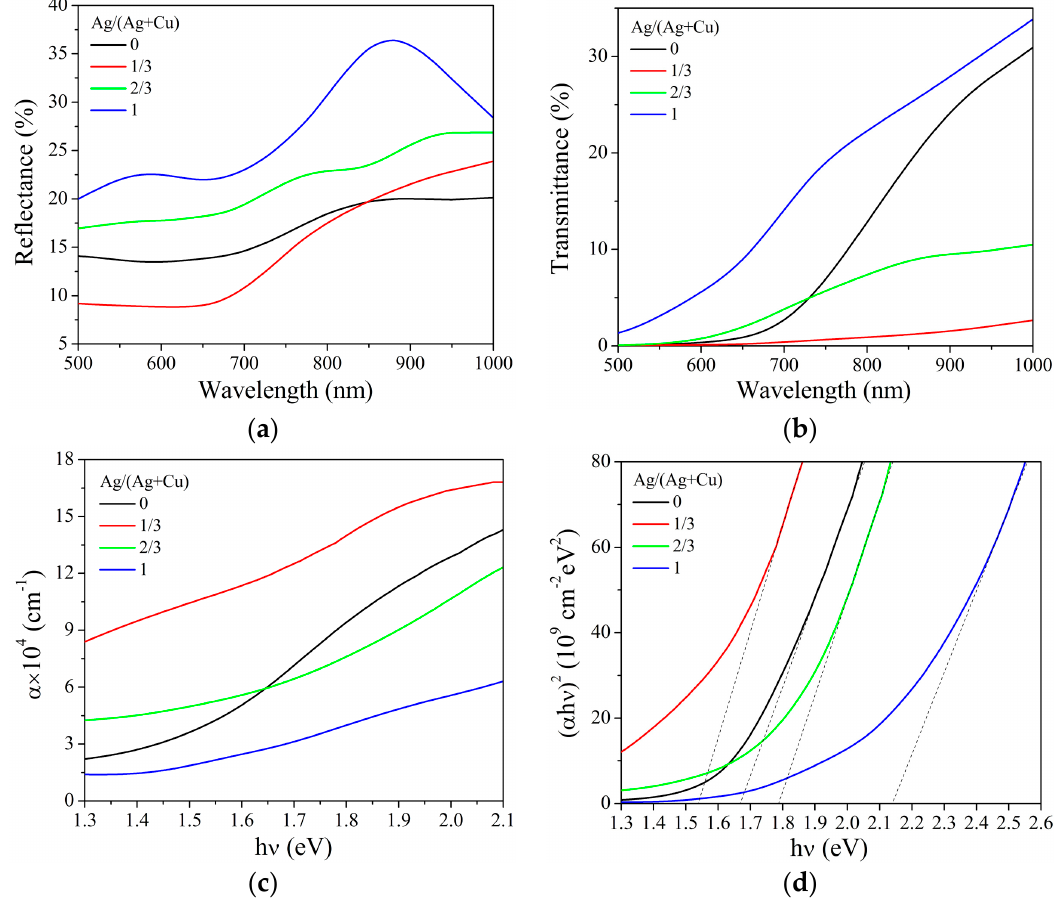
Figure 7. The ( a ) reflectance; ( b ) transmittance; ( c ) absorption coefficient; and ( d ) ( α h υ ) 2 versus h υ relations of Ag and Mn co-doped Cu 2 ZnSnS 4 thin films with different Ag/(Ag + Cu) ratios.